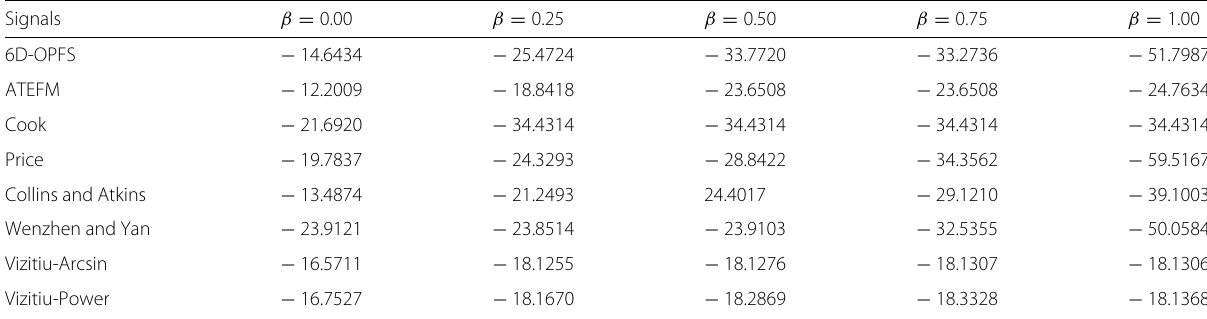
Table 2 PSLR of the parameterized signals computed with the parameters obtained from optimization routines Signals β = 0.00 β = 0.25 β = 0.50 β = 0.75 β = 1.00 ATEFM